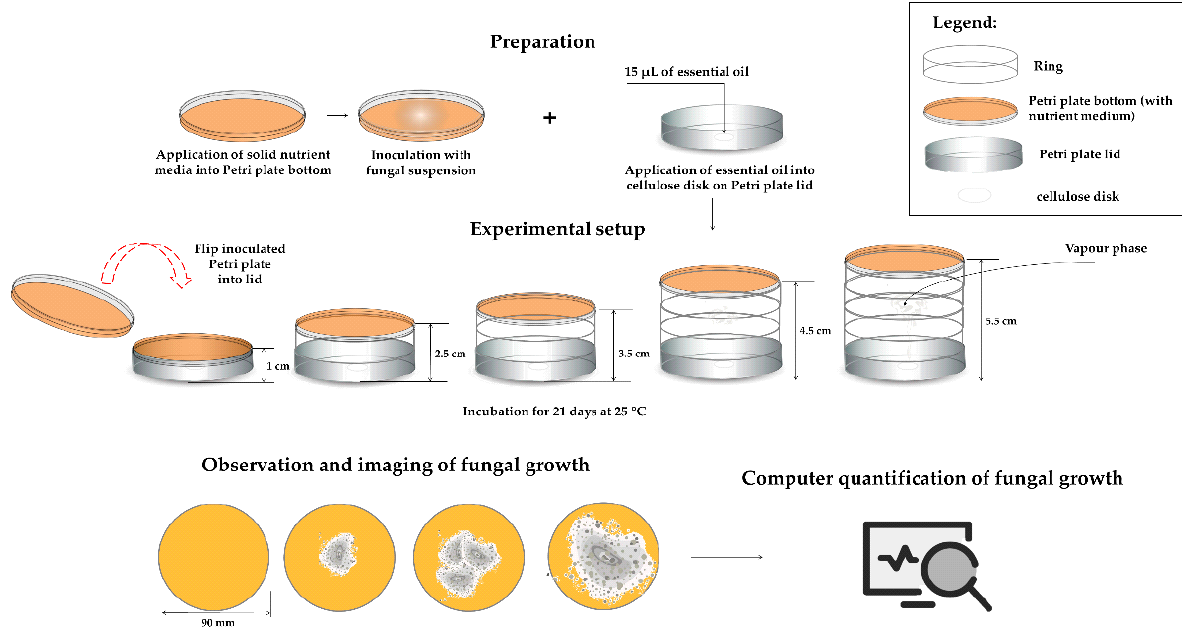
Figure 4. Schematic presentation of method for determination of EOs efficiency in vapour phase.